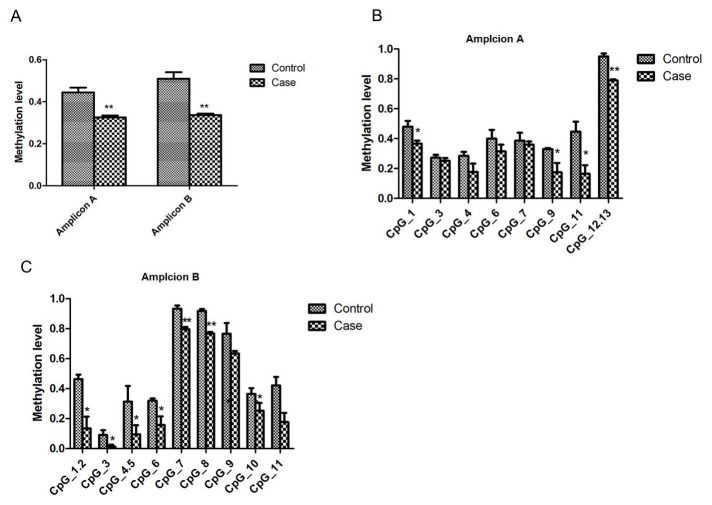
Validation of the methylation status of PTPRN2 in the two groups by MassARRAY EpiTYPER.(A)The overall methylation levels are displayed within amplicon A and amplicon B. (B,C) The average methylation of the CpG units of amplicon A and amplicon B are presented for late-onset severe PE and normal patients. Data are presented as means±SEM, n = 20 per group, *p<0.05,**p<0.01.A: Amplicon A, p = 0.0033;Amplicon B, p = 0.0017.B: Amplicon A: CpG_1, p = 0.0420; CpG_3, p = 0.4820; CpG_4, p = 0.1296; CpG_6, p = 0.2957; CpG_7, p = 0.6410; CpG_9, p = 0.0475, CpG_11, p = 0.0177; CpG_12.13, p = 0.0003. C: Amplicon B: CpG_1.2, p = 0.0134, CpG_3, p = 0.0210, CpG_4.5, p = 0.0185; CpG_6, p = 0.0163; CpG_7, p = 0.0019; CpG_8, p = 0.0001; CpG_9, p = 0.1268; CpG_10, p = 0.0192; CpG_11, p = 0.0583.